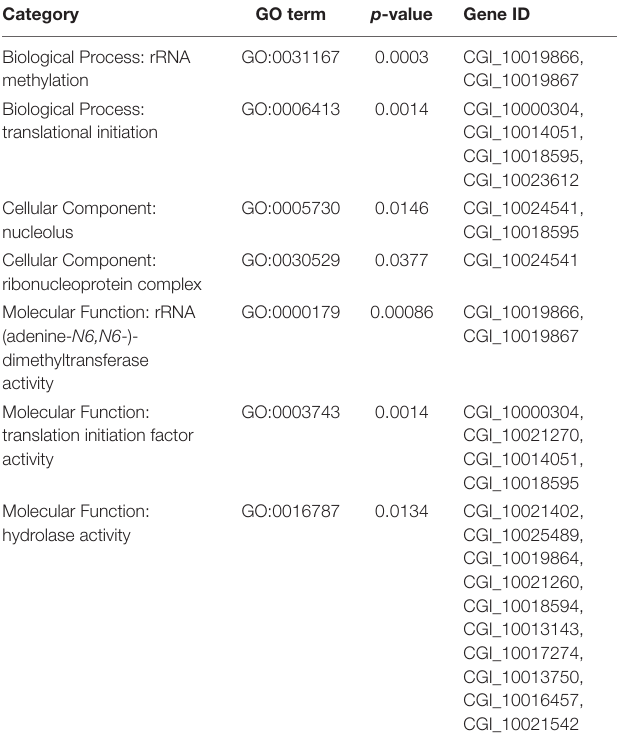
TABLE 3 | Gene ontology terms with P <